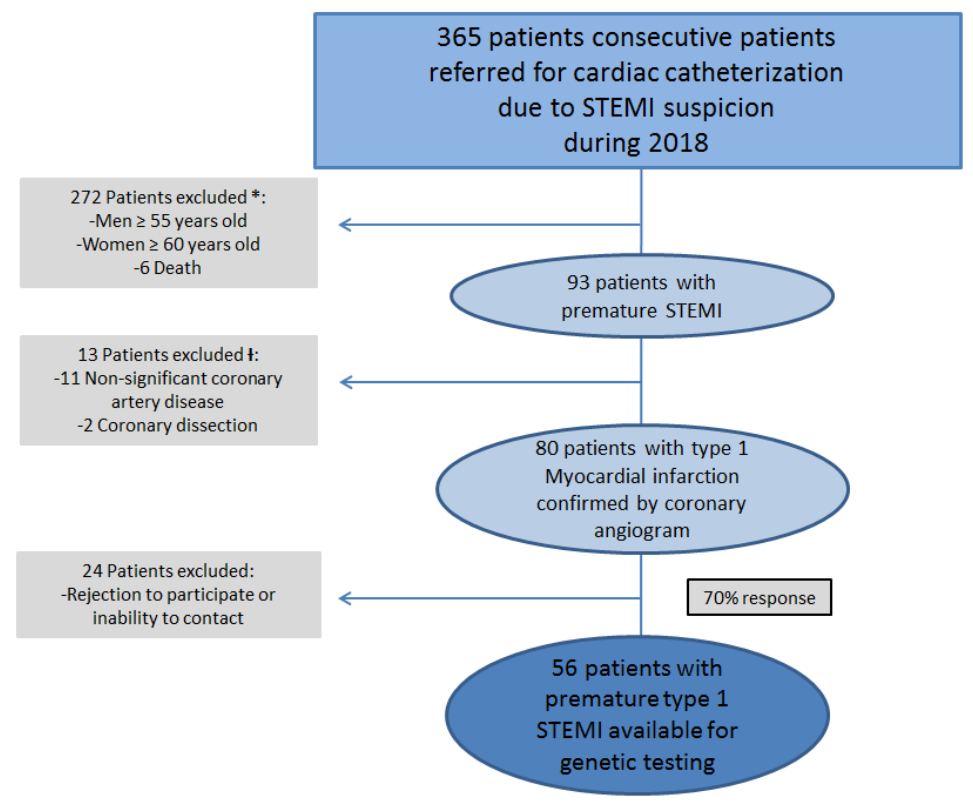
Figure 1. Patient selection. Flowchart showing steps for inclusion criteria. STEMI = Myocardial infarction with ST segment elevation; PCI = Primary percutaneous coronary intervention. * Premature CAD was defined according to DLCN criteria [7,8] as men <55 and women <60 years old. Ɨ Only STEMI due to type 1 MI confirmed by coronary angiogram were included.